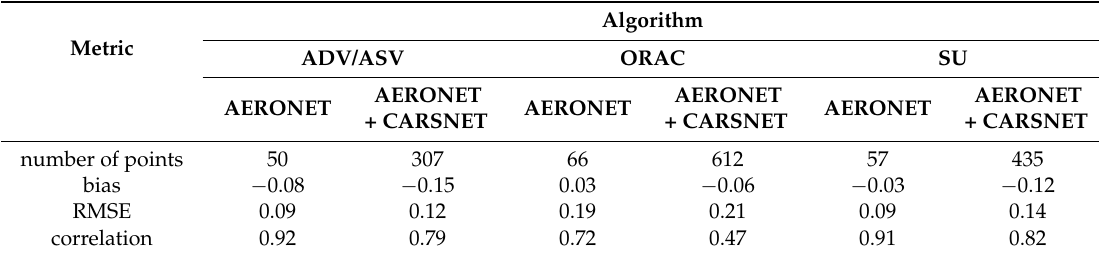
Table 8. Validation of AATSR L2 AOD products (ADV, ORAC and SU) with ground-based data in China for the year 2008 (AERONET alone, AERONET and